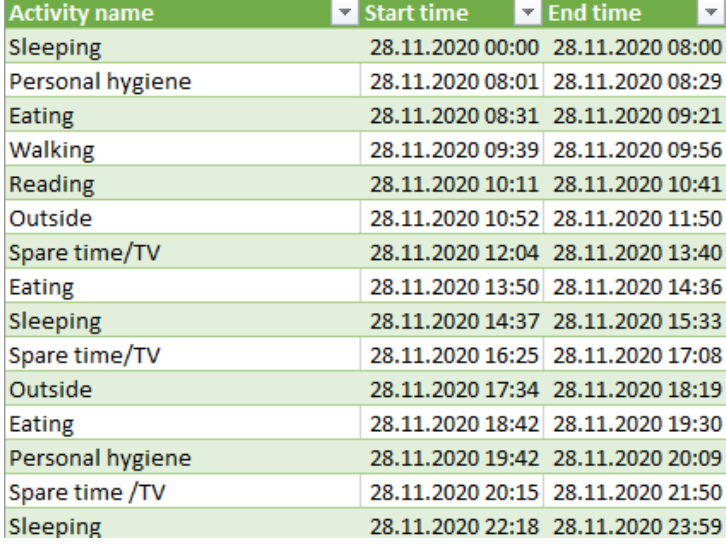
Figure 7. Activities of daily living monitored for a day.